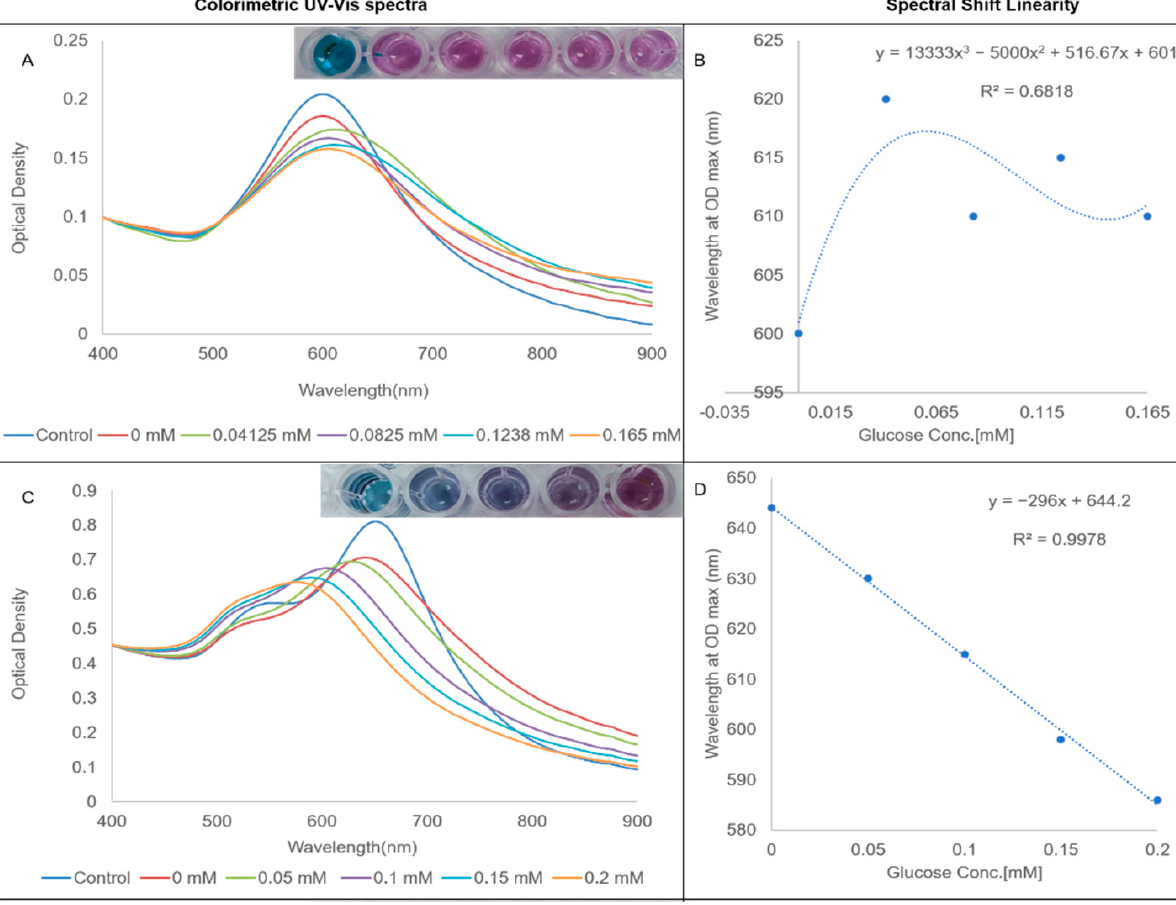
Figure 5. Glucose-sensing-efficacy-normalized UV-vis spectra and correlation curves: ( A , B ) AuNS- GOx; ( C , D ) AuNS-PVP-GOx; ( E , F ) AuNS-PEO-GOx; and ( G , H ) AuNS-PEG-GOx.